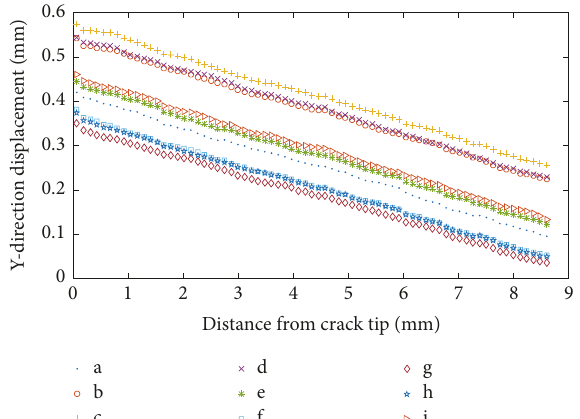
Figure 16: Displacements of points from the crack tip at characteristic load values within one stress cycle.